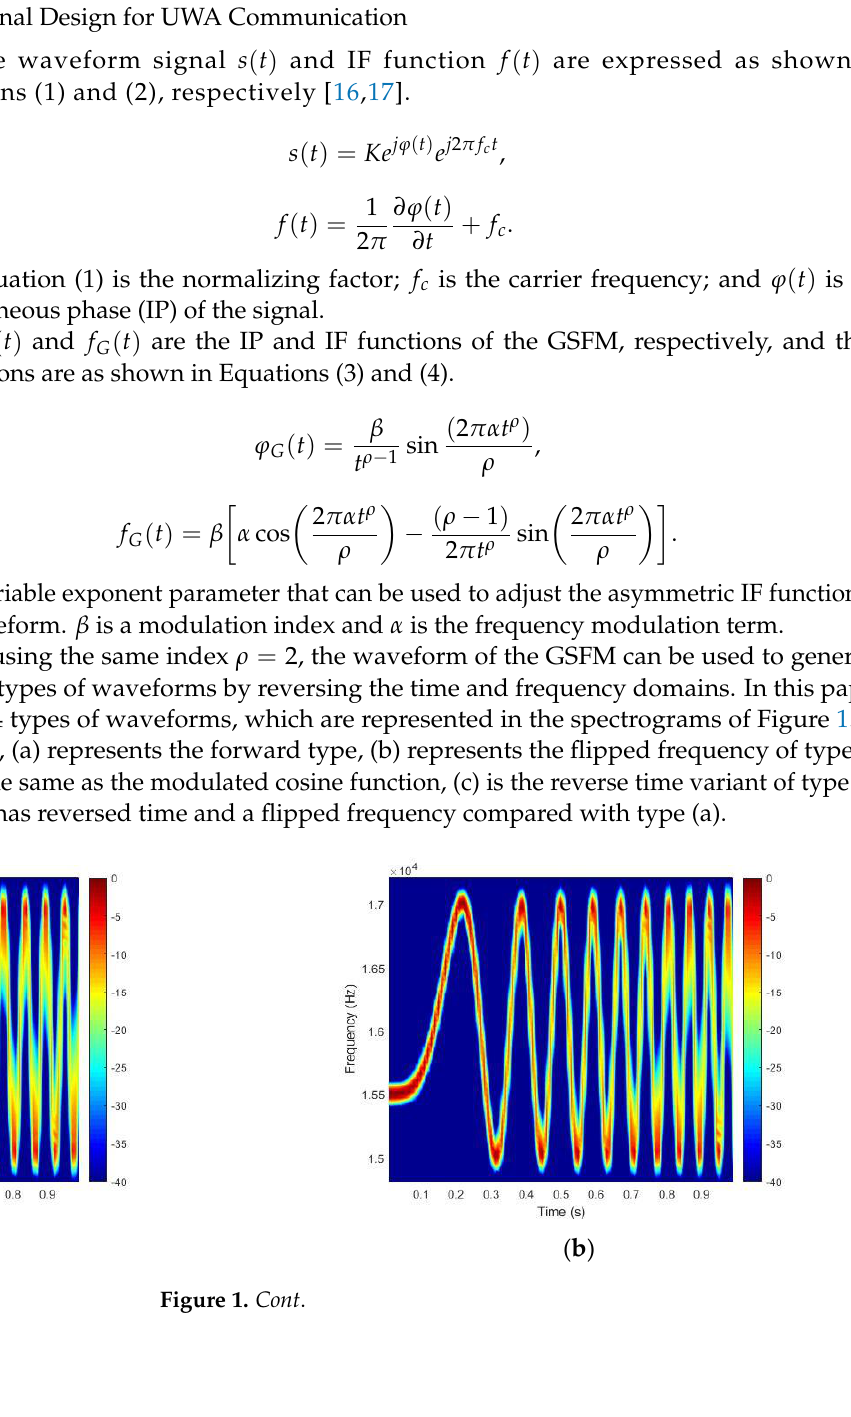
( d ) Figure 1. Four types of GSFM waveform spectrograms: ( a ) forward type, ( b ) forward-time/flipped-frequency, ( c ) reverse time, and ( d ) reverse-time/flipped-frequency. In this case, we assume that 𝑓 𝑐 is 16 kHz, the bandwidth is 2 kHz and the waveform length T is 1 s. In Figure 1, 𝛽 = 50, and 𝛼 = 20 is the same as 𝛼 = 𝐶/𝑇 𝜌 , which deter- mines the number of cycles 𝐶 = 10 . The four types of GSFM waveforms are orthogonal to each other. We expect the UWA communication performance to be more effective as a result of using the orthogonal characteristic of the GSFM AFs than that of the conventional LFM. In this paper, we use Equation (5), which is expressed as 𝑠 𝑖 (𝑡) = {𝑠 0 (𝑡), 𝑖𝑓 𝑏 2𝑛−1 𝑏 2𝑛 = 00 𝑠 1 (𝑡), 𝑖𝑓 𝑏 2𝑛−1 𝑏 2𝑛 = 01 𝑠 2 (𝑡), 𝑖𝑓 𝑏 2𝑛−1 𝑏 2𝑛 = 10 𝑠 3 (𝑡), 𝑖𝑓 𝑏 2𝑛−1 𝑏 2𝑛 = 11 , (𝑛 − 1)𝑇 ≤ 𝑡 < 𝑛𝑇 . (5) Here, 𝑠 0 (𝑡) is the forward-type waveform, 𝑠 1 (𝑡) is the forward-time/flipped-fre- quency-type waveform, 𝑠 2 (𝑡) is the reverse-time-type waveform and 𝑠 3 (𝑡) is the re- verse-time/flipped-frequency-type waveform of the GSFM. 𝑏 𝑛 is the n -th bit sequence, T is the length of the symbol, and each symbol represents a 2-bit sequence. The block diagram of the proposed method is shown in Figure 2. The received signal that passes through a channel leaves only the band energy using a band pass filter and uses preamble for fine synchronization of the data packet. Finally, the outputs of each matched filter are compared to find the maximum value.